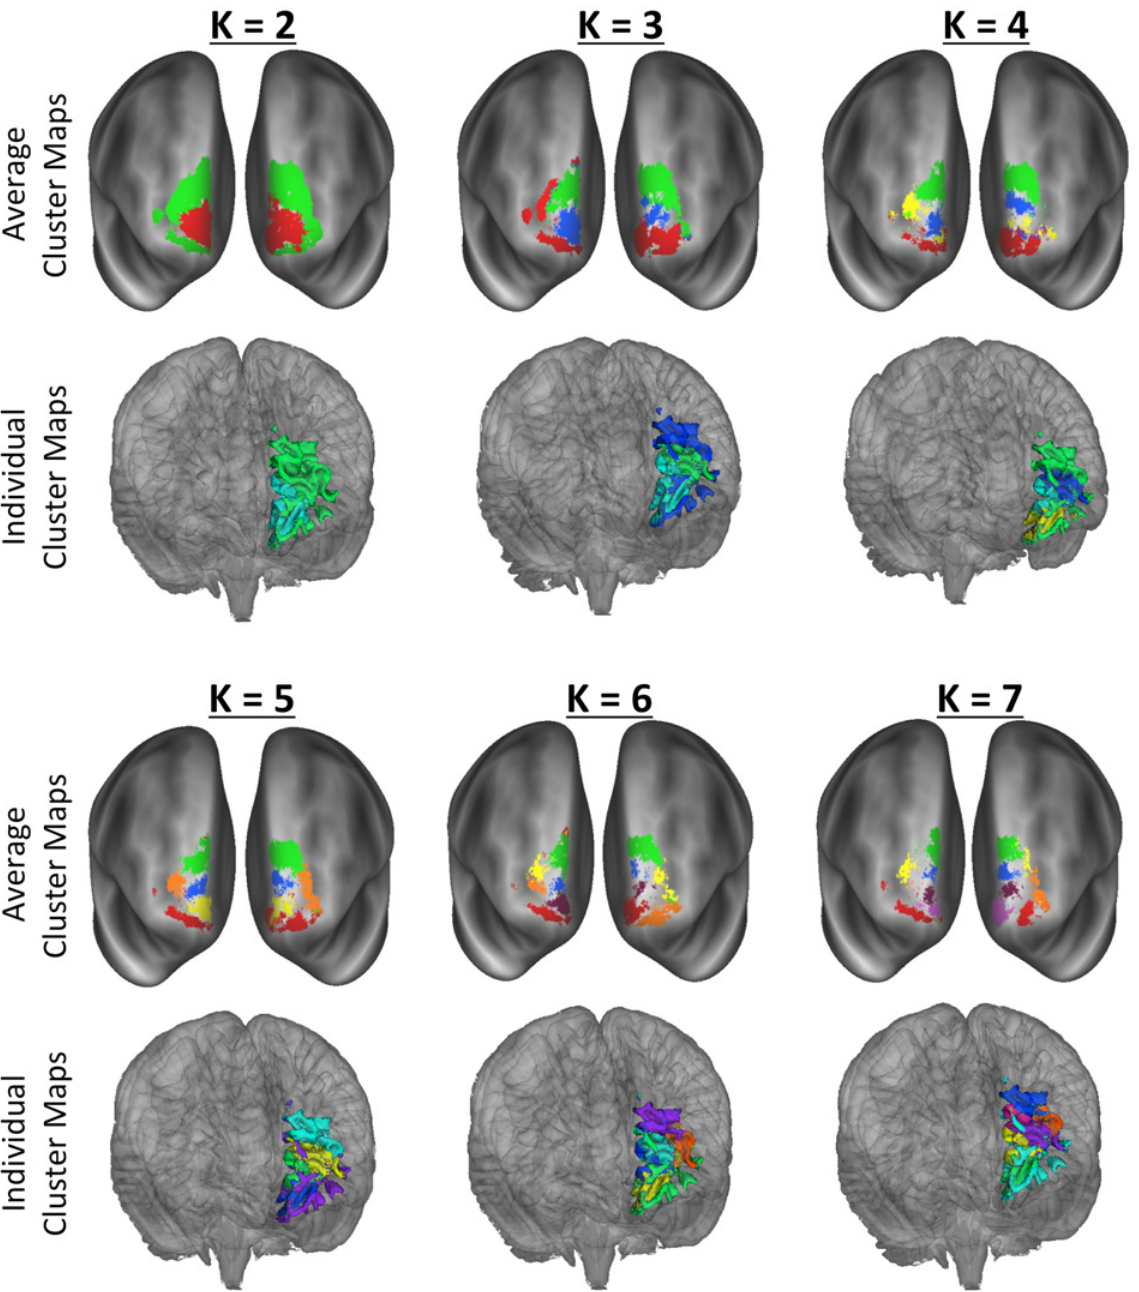
Fig 8. Cluster maps for all clustering solutions for the frontal pole as defined by the Bludau cytoarchitectonic atlas with data from 30 participants from the Human Connectome Project. The Average Cluster Maps were created by dilating the surface maps for each subject with a 2mm spherical kernel, and averaging the resulting maps. The averaged maps shown here were thresholded to only show voxels where the cluster was present in at least 50% of the participants. Colors in the average cluster maps correspond to the closest cluster in Fig 2. The Individual Cluster Maps show the undilated cluster maps from one representative participant (as noted in the text, the undilated surfaces are difficult to average together). The images are from an off-center anterior view in order to show the medial surfaces. Colors in the individual maps do not correspond to the average cluster maps due to graphics software